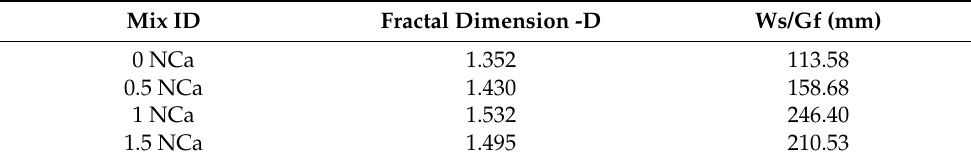
Figure 13. Fractal dimensions of the ( a ) 0 NCa, ( b ) 0.5 NCa, ( c ) 1 NCa, and ( d ) 1.5 NCa samples. Table 5. The summary of the fractal analysis of the mixtures. Table 5. The summary of the fractal analysis of the